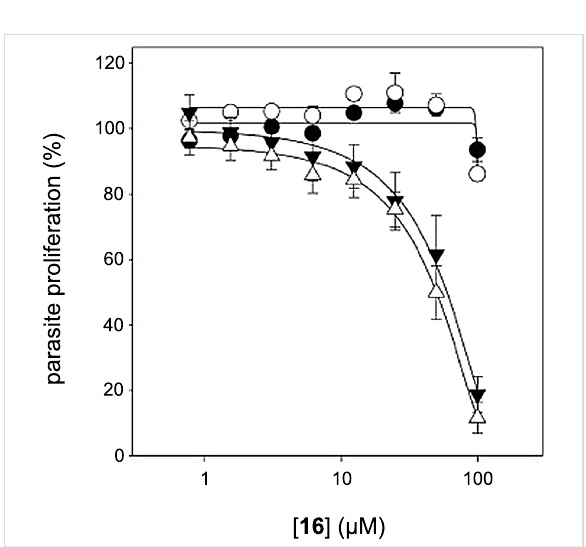
Figure 3: In vitro antiplasmodial activity of compound 16 in growth me- dium containing pantetheinase (open symbols) or in medium in which the pantetheinase had been inactivated (dark symbols). The antiplas- modial activity of this compound can be antagonized by increasing the extracellular concentration of pantothenate from 1 µM (triangles) to 100 μ M